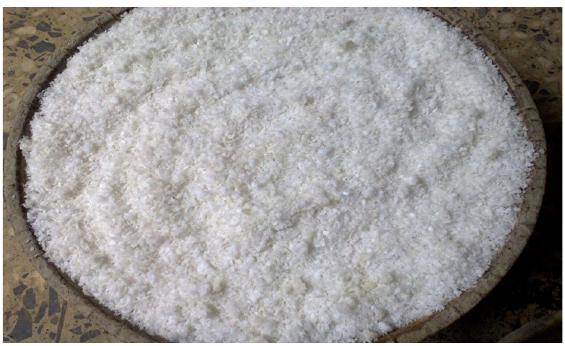
Fig. 1. Polypropylene grain